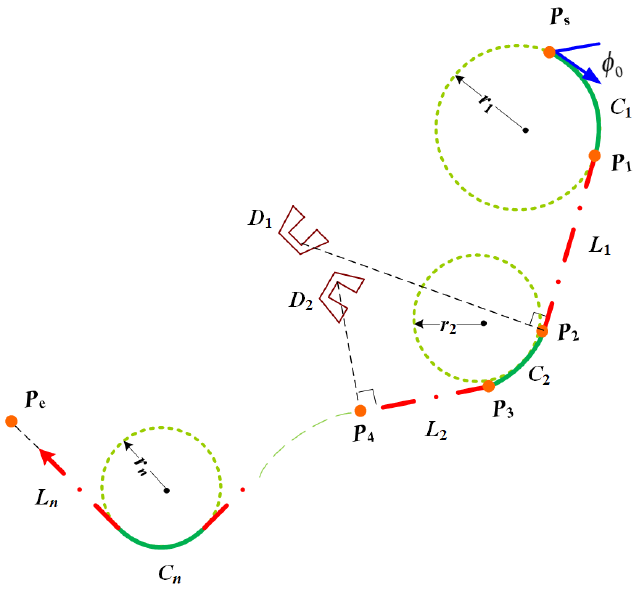
Figure 11. Distributed local path planning